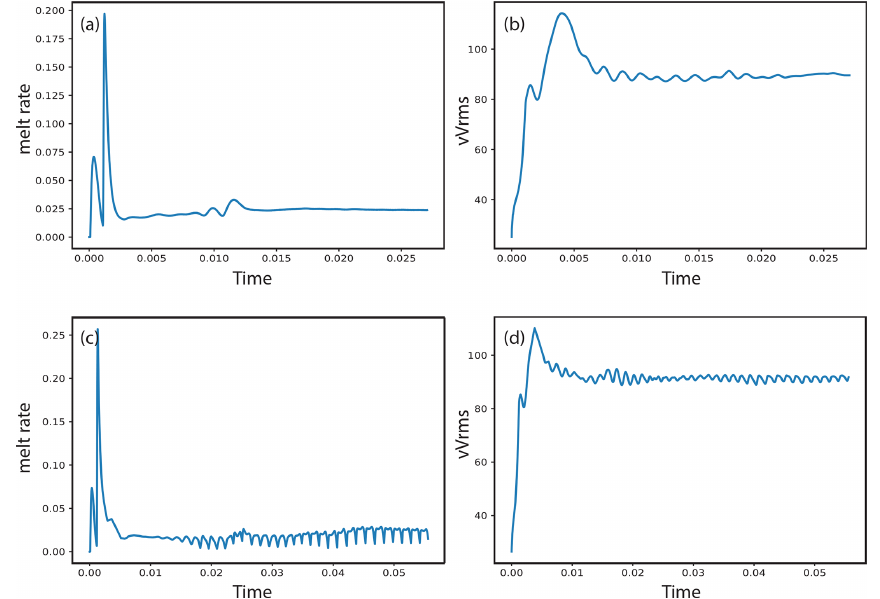
Figure A1. Example of trends used to evaluate steady state in our models. Shown are the reference case ( a and b ; see also Fig. 3) and the case of D plume = 400km, (cid:49)T plume = 150 ◦ C and B plume = 100kgs − 1 ( c and d ; see also Fig. 7b and Supplement). Panels (a) and (c) show the total melting rate (integrated across the whole model) and (b) and (d) show the root mean square of the vertical velocity (vVrms). All axes are in non-dimensional scale.